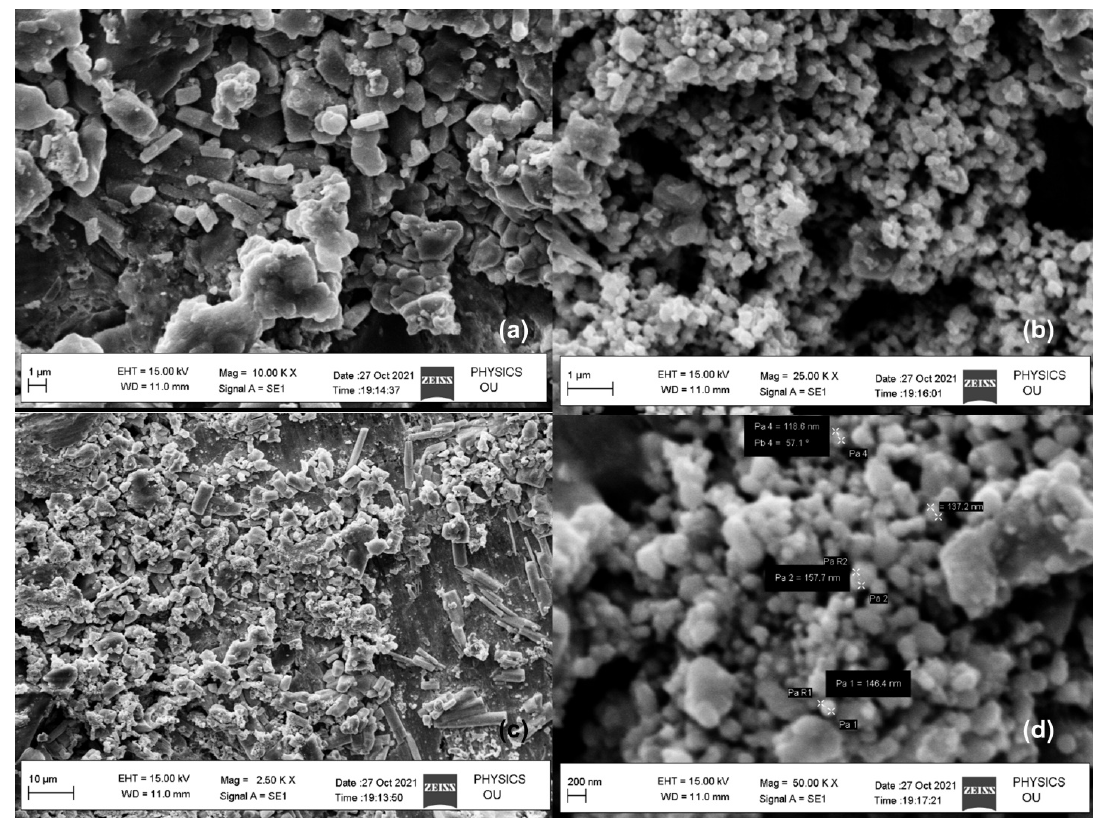
Figure 7. SEM analyses of biosynthesized silver nanoparticles ( a – d ).